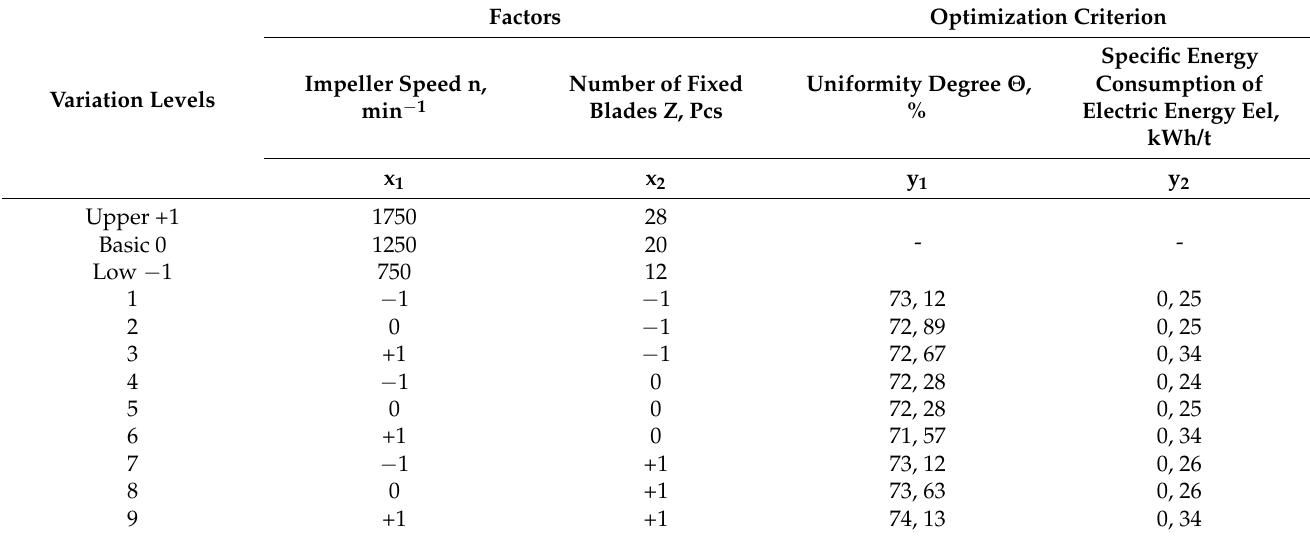
Table 2. Results of research according to the plan presented in Table